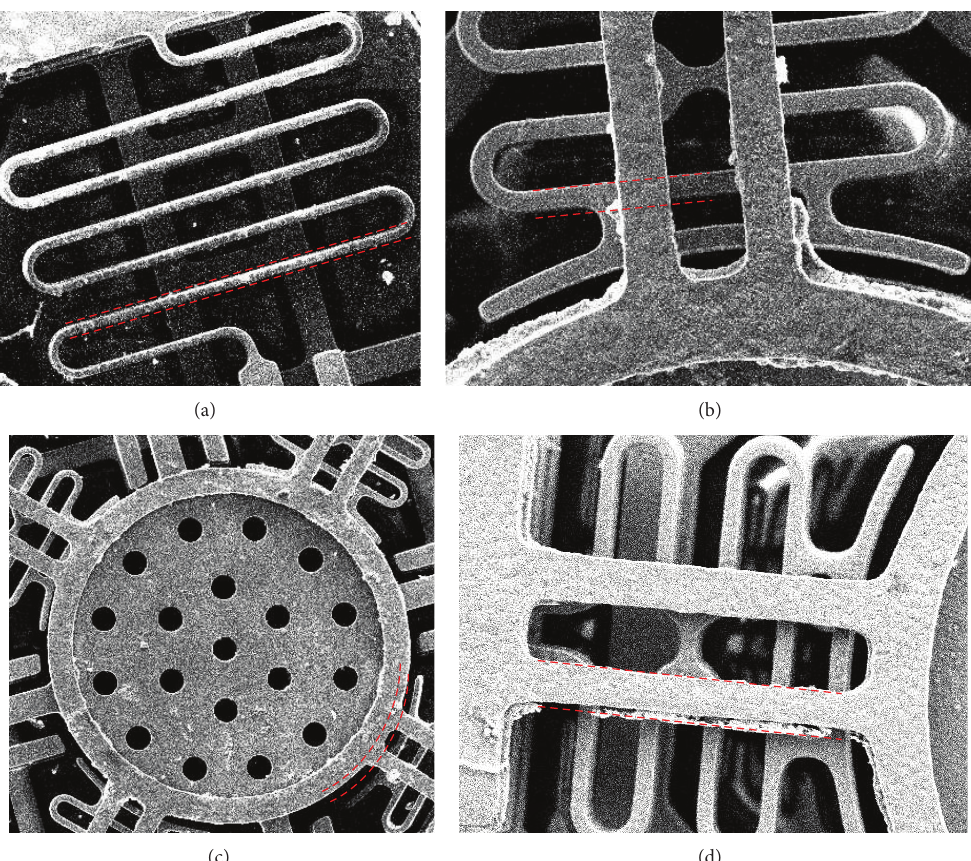
Figure 12: Fabrication errors of the switch (a) width of the proof mass spring decreasing, (b) width of the radial electrode spring decreasing, (c) radial gap increasing, and (d) width of the crossbeam decreasing.